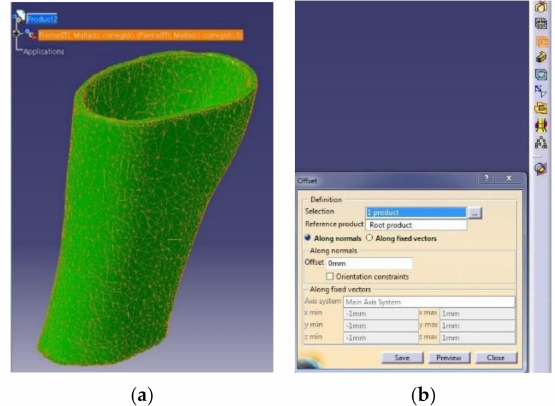
Figure 6. Catia Software. Reduced mesh ( a ) and offset tool ( b ).